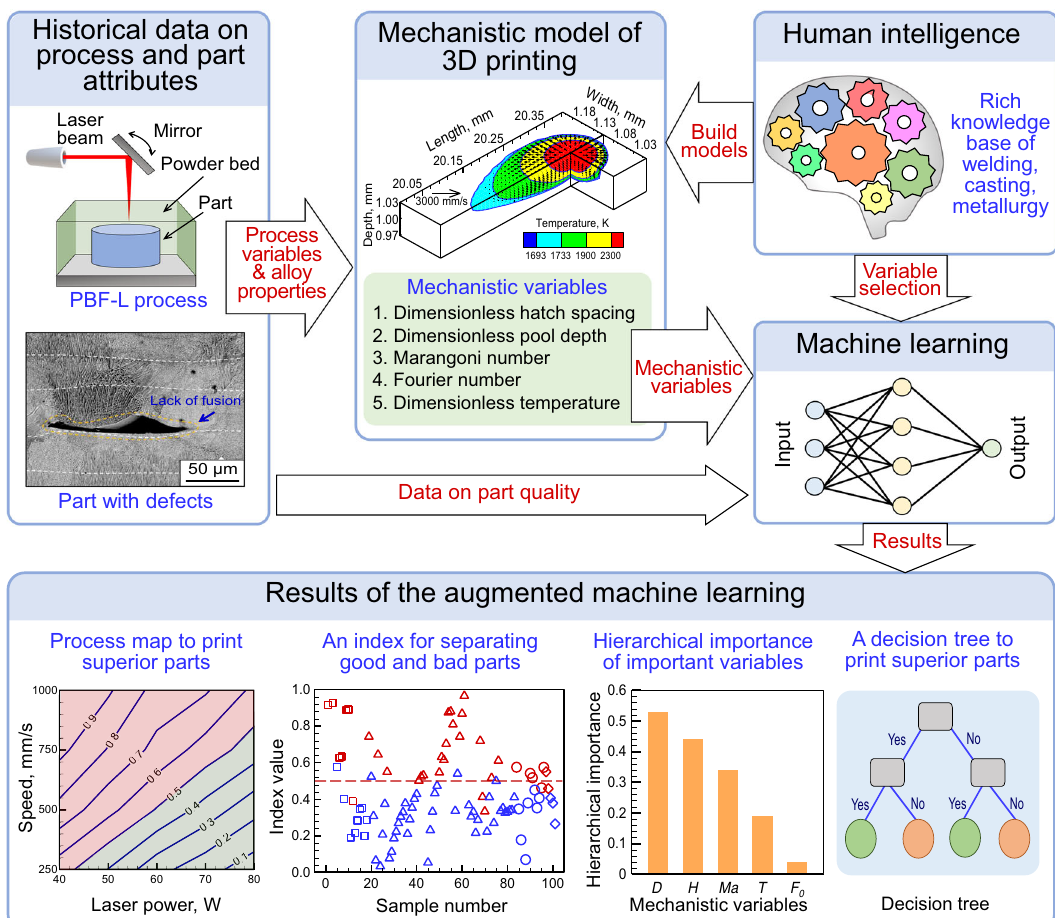
Fig. 1 Schematic representation of the methodology used. Process variables used in the experiments and the thermophysical properties of alloys are used in the mechanistic model to calculate the fi ve mechanistic variables that in fl uence the lack of fusion defect formation. These variables when used to train augmented machine learning algorithms can guide engineers to fi nd out conditions for avoiding the lack of fusion defects in printed metallic parts. The experimentally observed lack of fusion defect 60 is for Inconel 718 made by powder bed fusion. The panel “ Part with defects ” is adapted with permission from reference 60 , Elsevier. The panel “ Human intelligence ” is adapted with permission from reference 61 ,